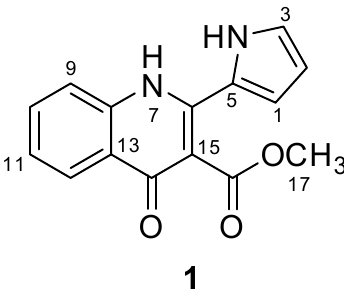
Figure 1. Chemical structure of methylpenicinoline ( 1